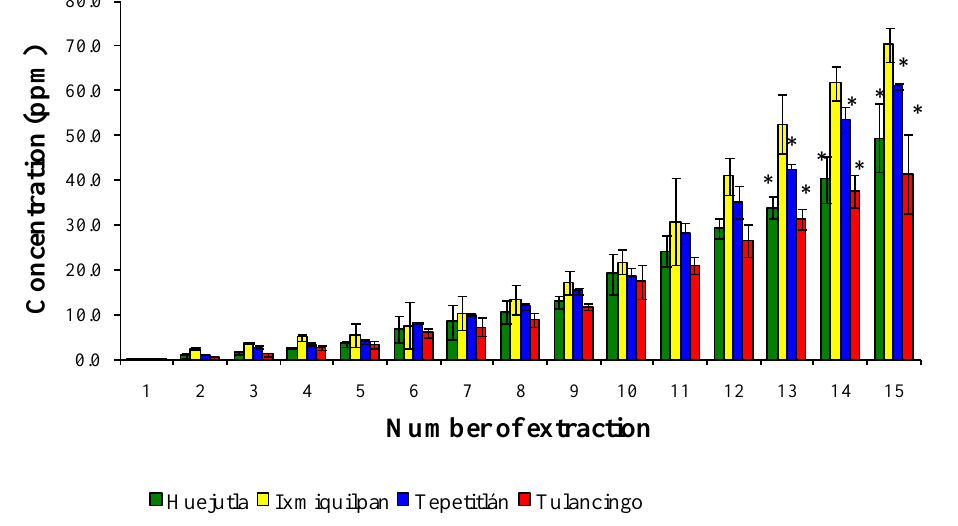
Figure 8. Concentration of Co leached from the glass-clay containers into acetic acid. The bars show the mean values of the four regions with their standard deviations. * Indicates significant statistical differences with respect to the Ixmiquilpan region, which represents the highest concentration of the metal; p ≤